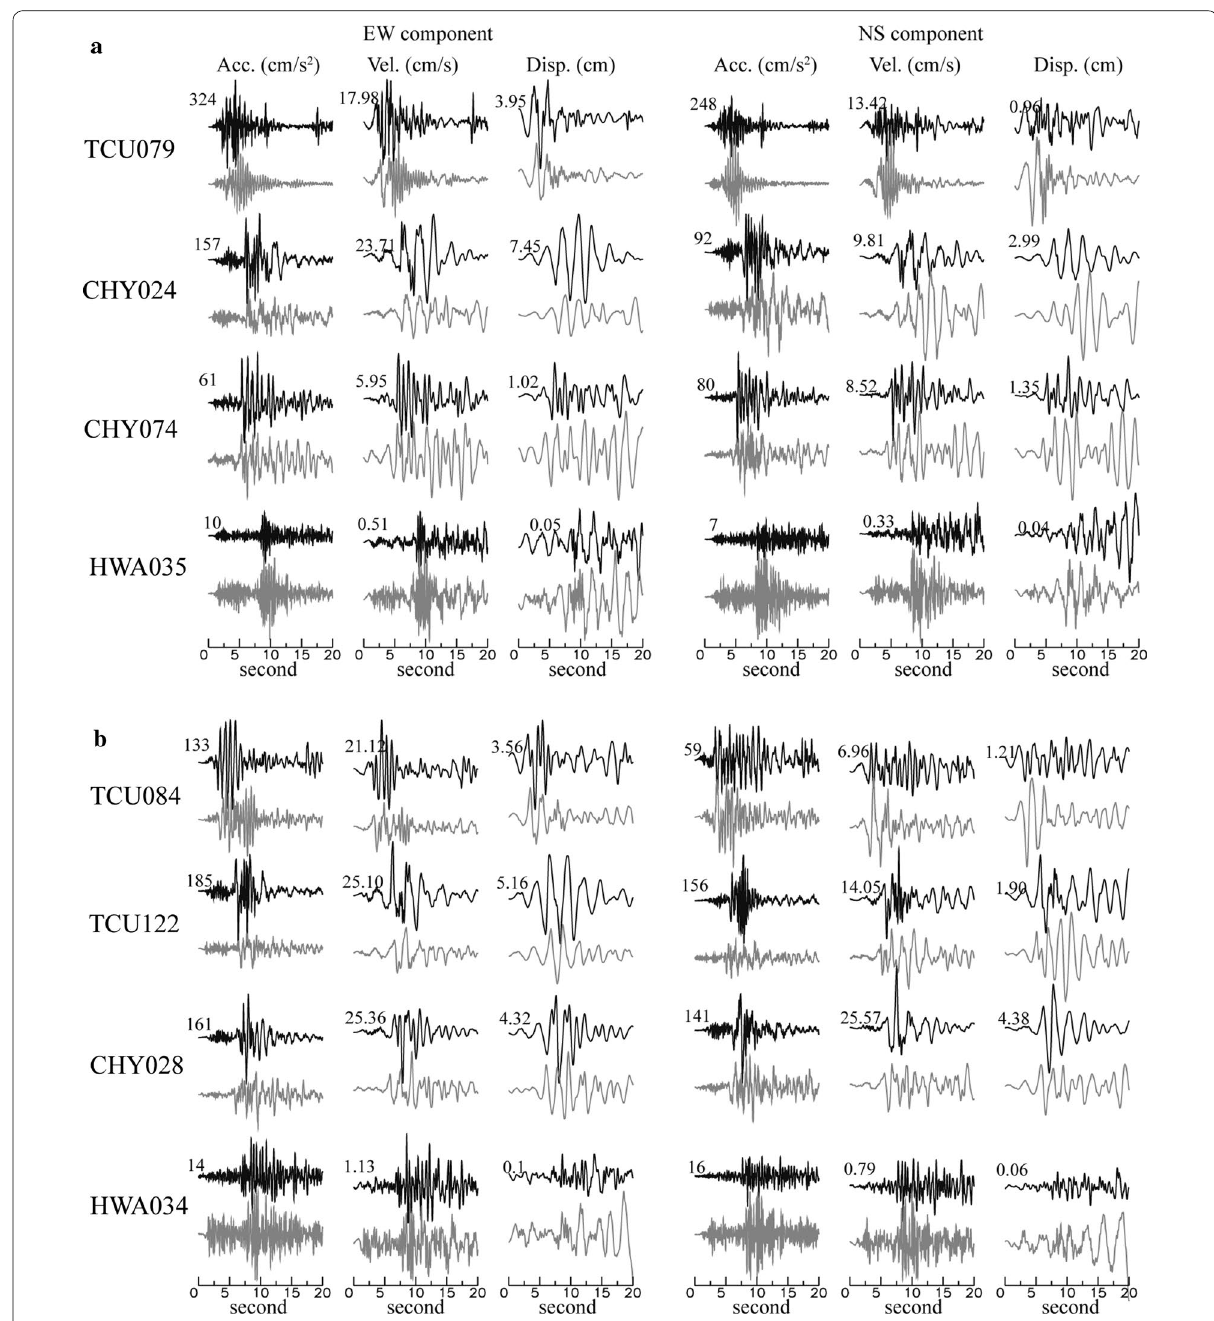
Fig. 3 Comparison of observed (black lines) and synthetic (gray lines) waveforms of event E1 at strong motion stations used for a the source mod‑ eling through the empirical Green’s function method (solid triangles in Fig. 2a) and b forward ground motion simulations (open triangles in Fig. 2a), with the number indicating the maximum amplitudes of the observed records for acceleration (cm/s/s), velocity (cm/s) and displacement